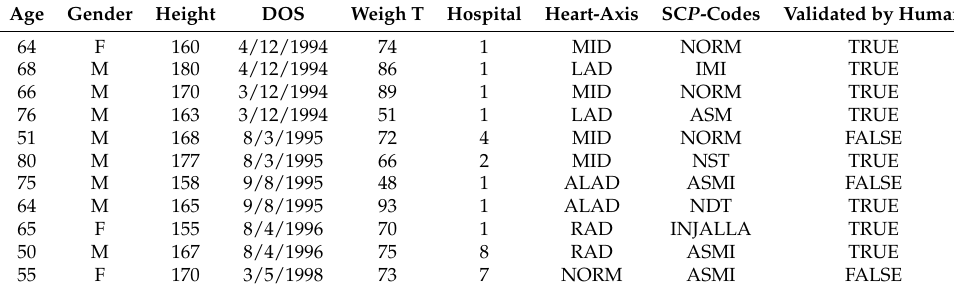
Table 5. High-dimensional raw data.